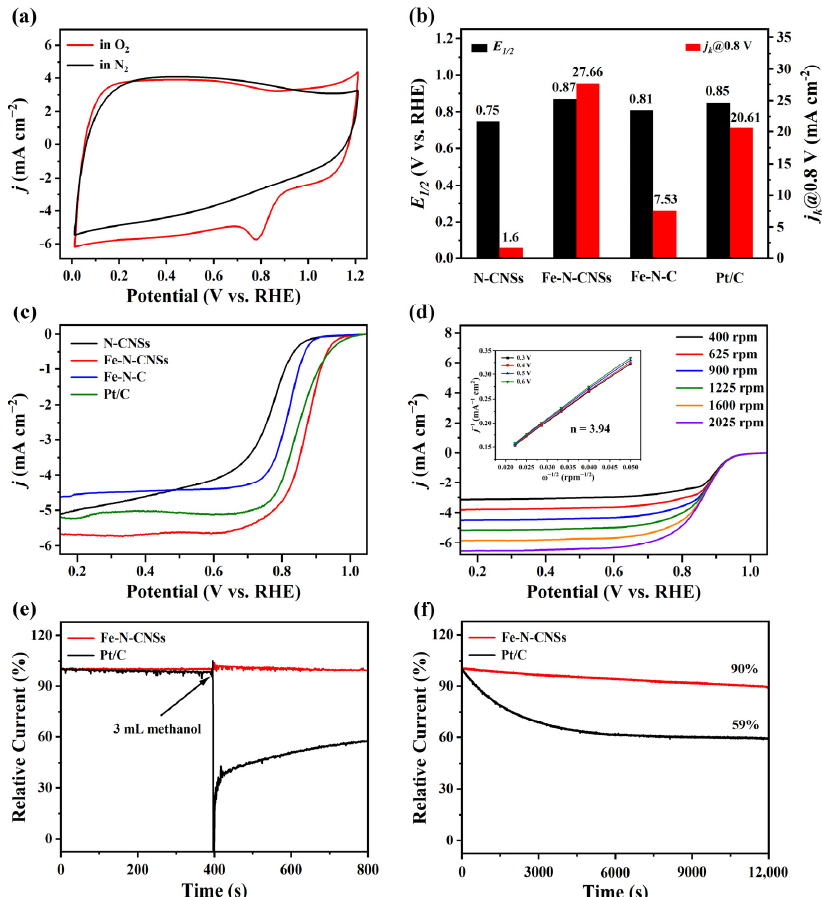
Figure 3. ( a ) CV curves of Fe-N-CNSs in O 2 /N 2 saturated electrolyte. ( b ) LSV curves of the synthe- sized materials and Pt/C. ( c ) E 1/2 together with j k @0.8 V towards these materials. ( d ) LSV curves of Fe-N-CNSs at different rotational speeds and the K-L plots. ( e ) Methanol tolerance and ( f ) i-t curves of Fe-N-CNSs and Pt/C.